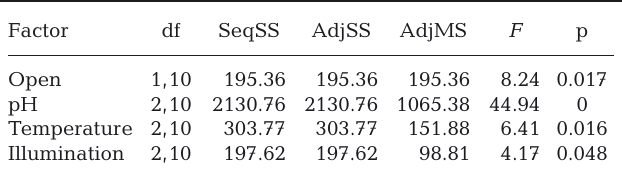
Table 4. ANOVA of the half-life data of the L18 (2×3 3 ) orthogonal experiment. SeqSS: continuous SS; adjSS: adjusted SS; adjMS: ad- justed MS. Data are significant at p <